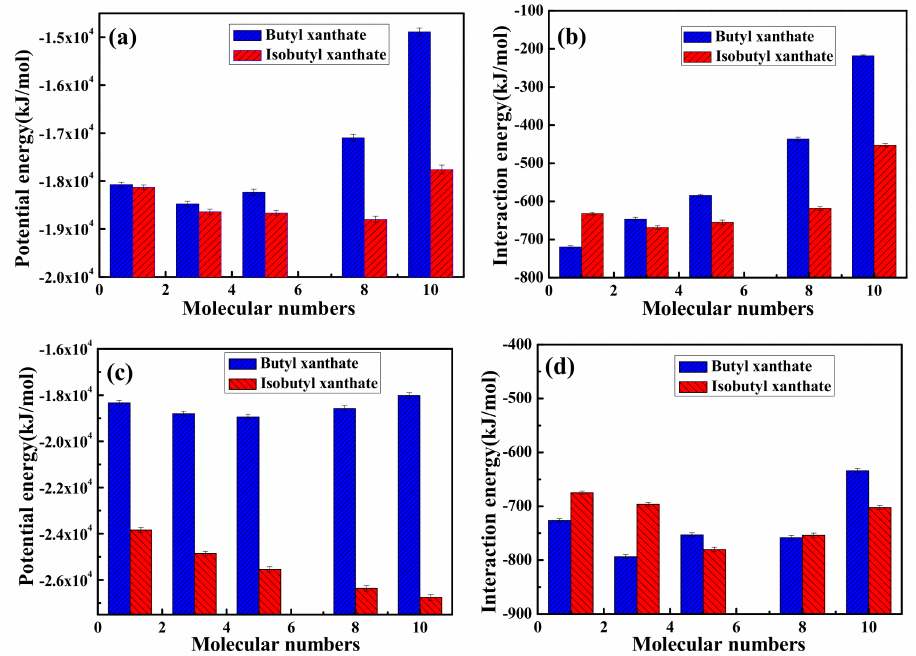
Figure 6. Potential and Interaction energies between pyrite surface and xanthate solution for NVT ( a , b ) ensemble or NPT; ( c , d )